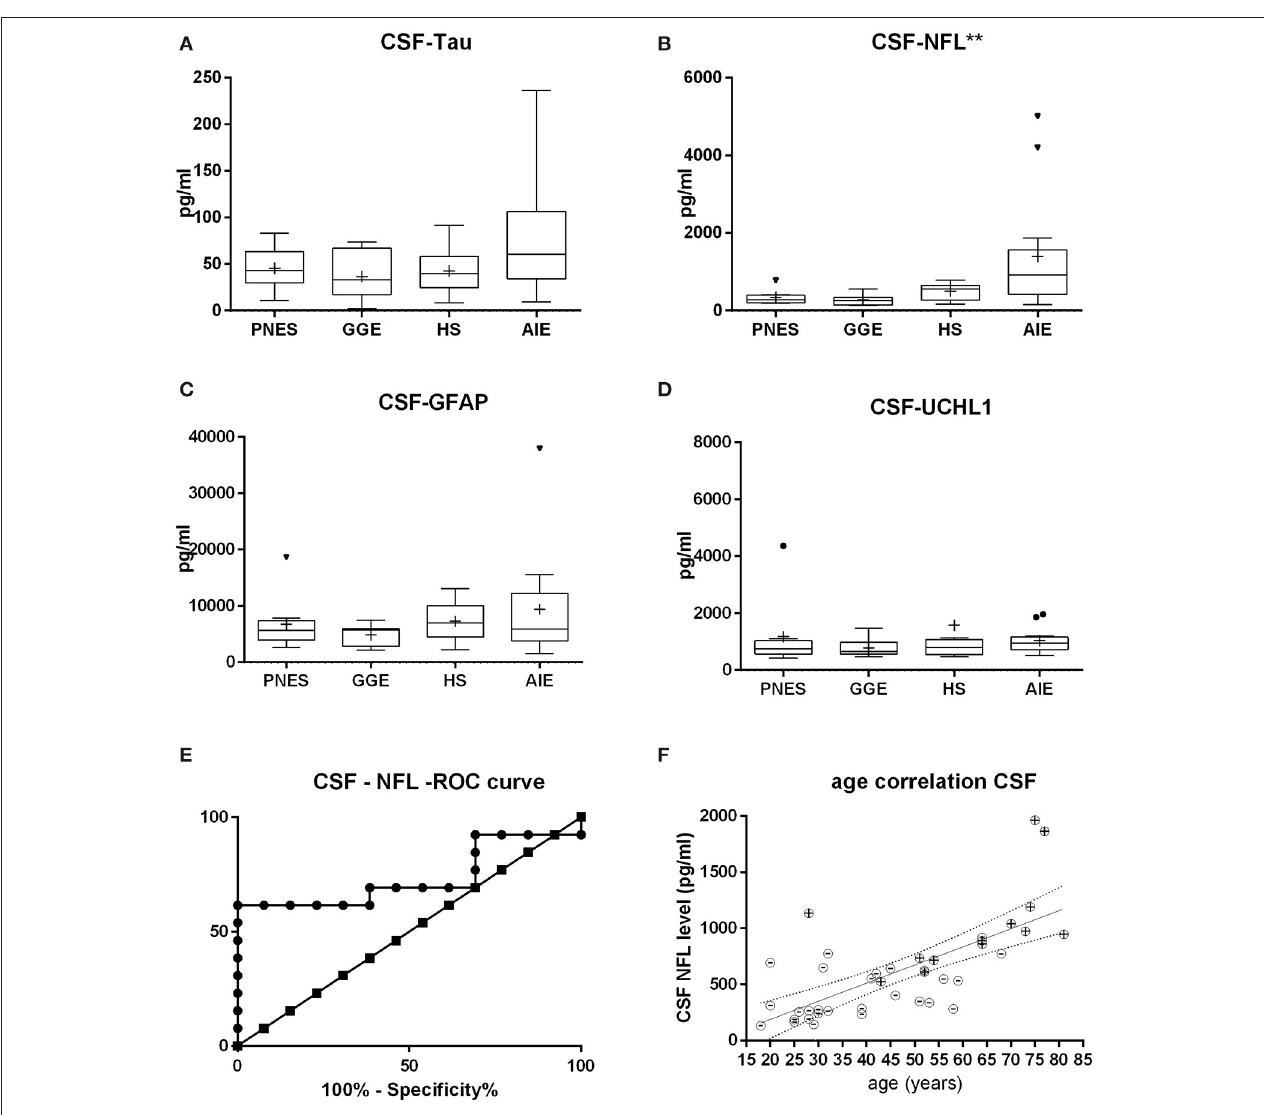
FIGURE 2 | Cerebrospinal fluid (CSF) levels of tau (A) , neurofilament (NFL) (B) , glial fibrillary acid protein (C) , and ubiquitin-carboxy-terminal hydrolase L1 (D) . NFL shows the most statistically significant difference in between groups, followed by tau. At first glance, the receiver operating characteristic curve (E) indicates that CSF NFL may be of decent value in the question on whether epilepsy might be autoimmune-related. Of note is the fact that this may likely be a result of age alone since age strongly correlates with NFL levels both in AIE (“ + dots”) as in other etiologies (“-dots”) (F) . * p < 0.05, ** p <